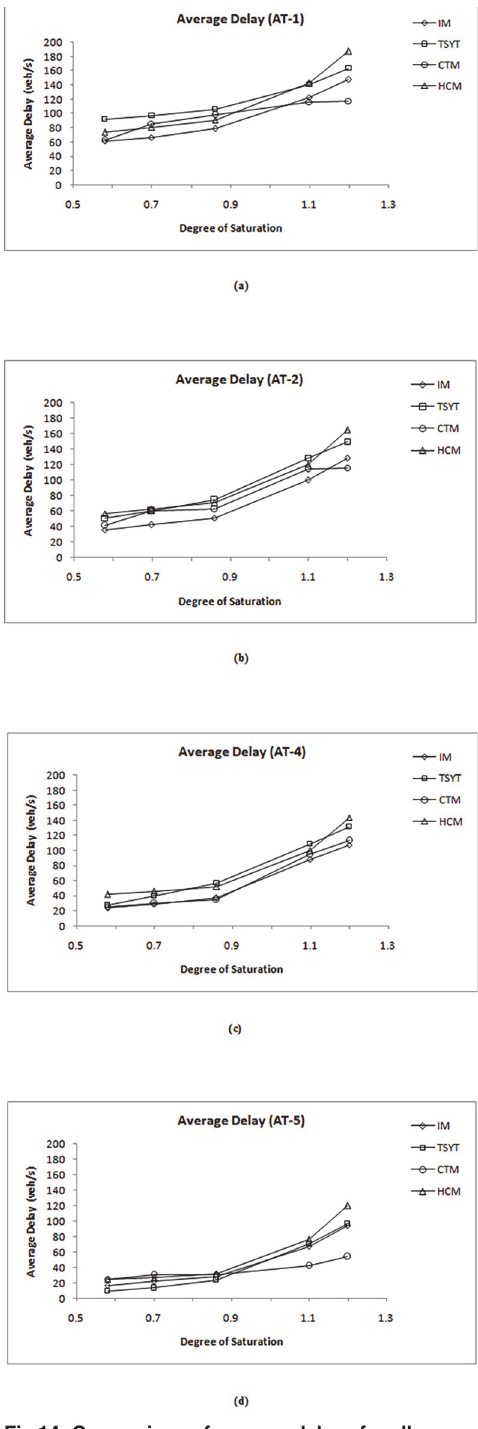
Fig 14. Comparison of average delays for all scenarios.